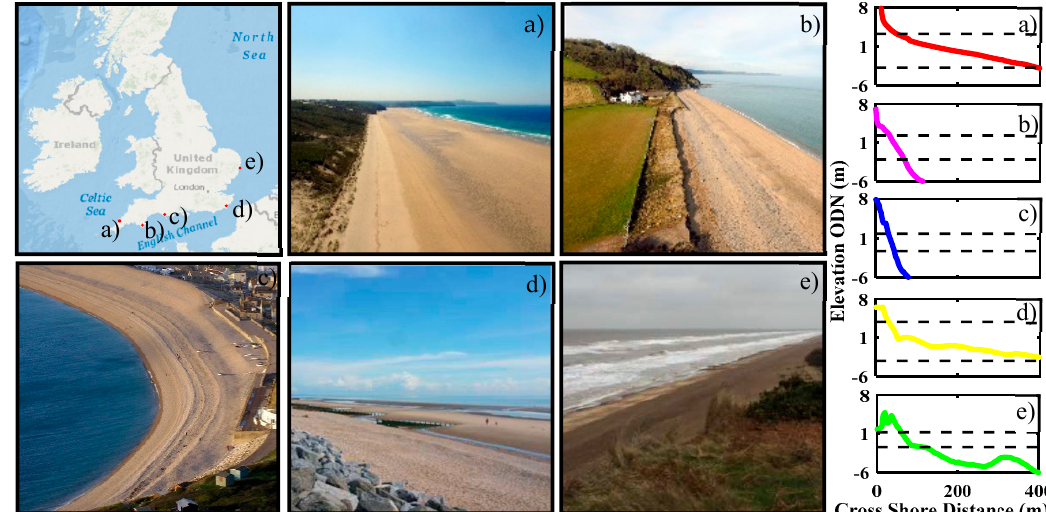
Figure 2. Location (top left corner), photographs (left), and representative profiles (to the right of the photographs) of ( a ) Perranporth (PPT), ( b ) Beesands (BEE), ( c ) Chesil (CSL), ( d ) Camber (CAM), and ( e ) Minsmere (MMR). Dashed black lines on the profiles represent mean high and low water spring tidal elevation. The Chesil photograph ( c ) is licensed under the Creative Commons Attribution-Share